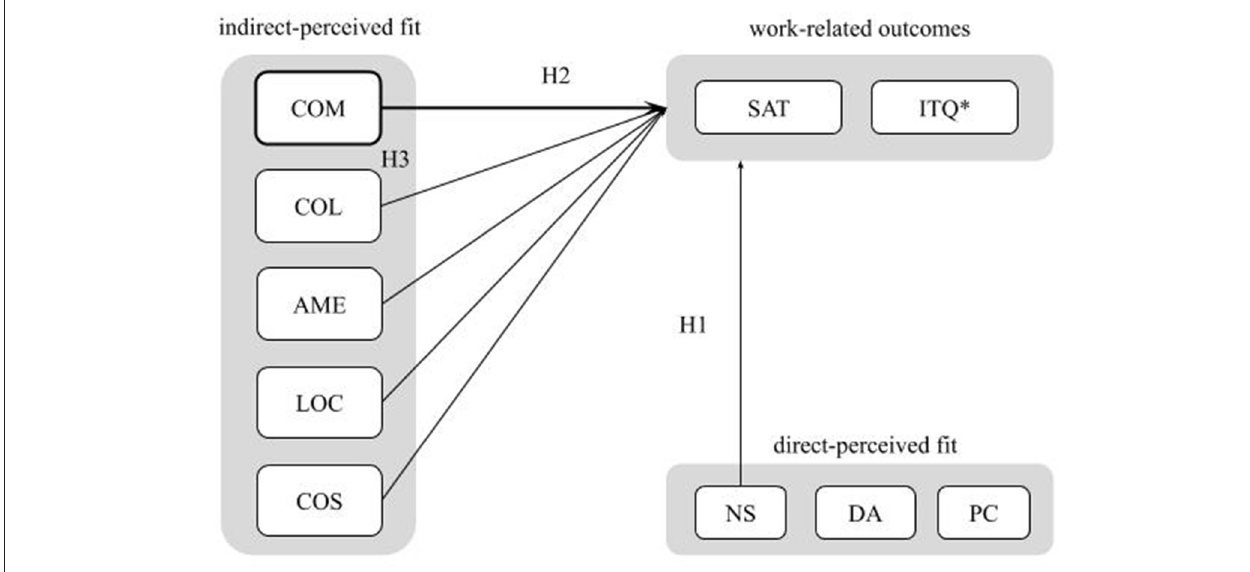
FIGURE 1 | Conceptual model. COM, community; COL, collaboration; AME, amenities; LOC, location; COS, cost; SAT, job satisfaction; ITQ, intent to quit; *, negative outcome; NS, needs-supplies fit; DA, demands-abilities fit; PC, person-coworking space fit (supplementary